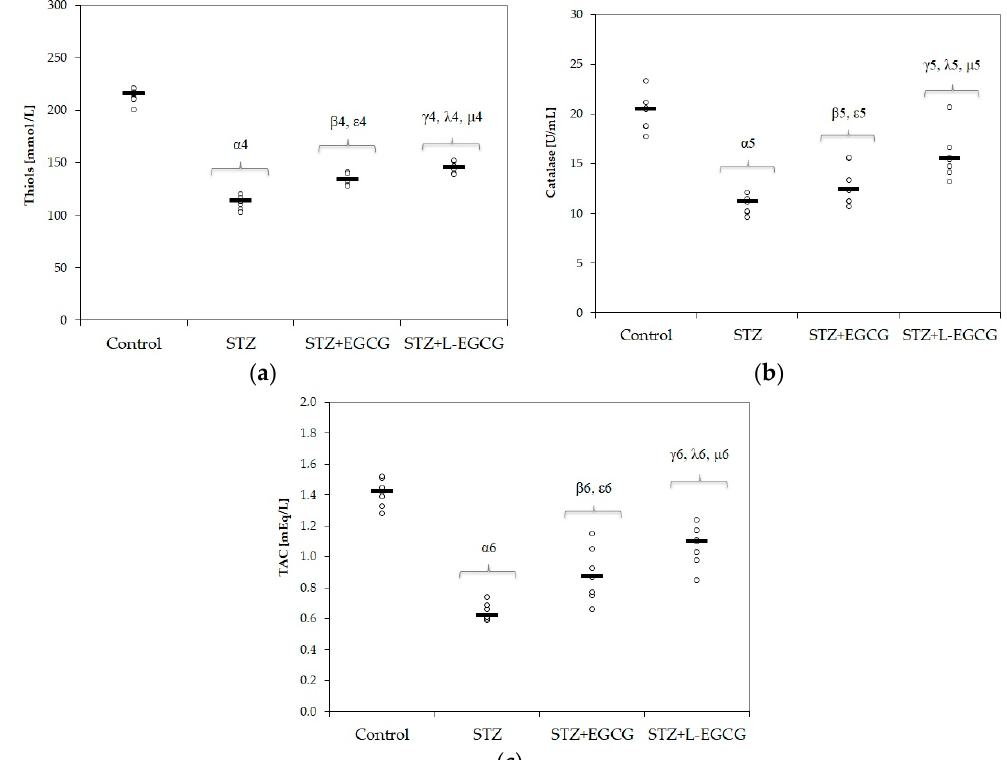
Figure 2. Distribution of plasmatic antioxidant capacity by groups: ( a ) Thiols, ( b ) Catalase, ( c ) TAC (total antioxidant capacity) on all study groups (7 rats/group). STZ = streptozotocin control; STZ + EGCG = STZ and EGCG solution i.p. as pretreatment; STZ + L-EGCG = STZ and liposomal EGCG i.p. as pretreatment. The symbol–number codes correspond to the p -values < 0.05 as follows: α —STZ compared to control; β —STZ + EGCG compared to control; ε —STZ + EGCG compared to STZ; γ —STZ + L-EGCG compared to control; λ —STZ + L-EGCG compared to STZ; µ —STZ + L-EGCG compared to STZ + EGCG